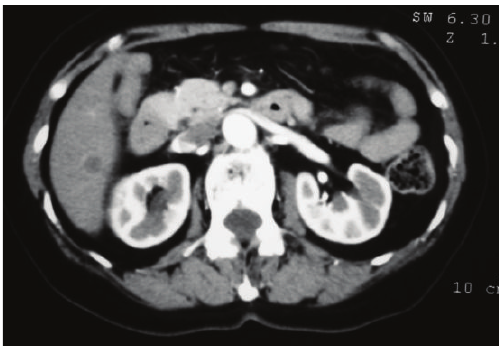
Figure 2: On the cut section of the surgical specimen, a 1.2 × 1.2 cm sized, homogeneous, whitish-yellow-colored nodule with central small cystic area was observed in the liver segment IV. The nodule was well demarcated from surrounding normal liver tissue with the fibrous capsulation.